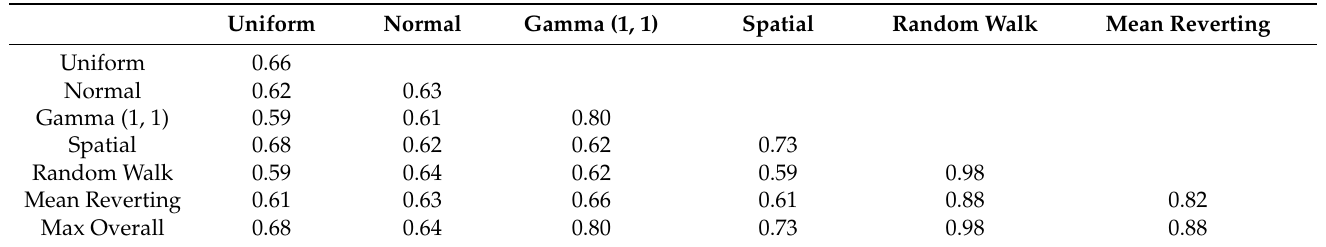
Table 2. Maximum spurious correlations in simulations testing 1,000,000 pairs of random variables following specified distributions.